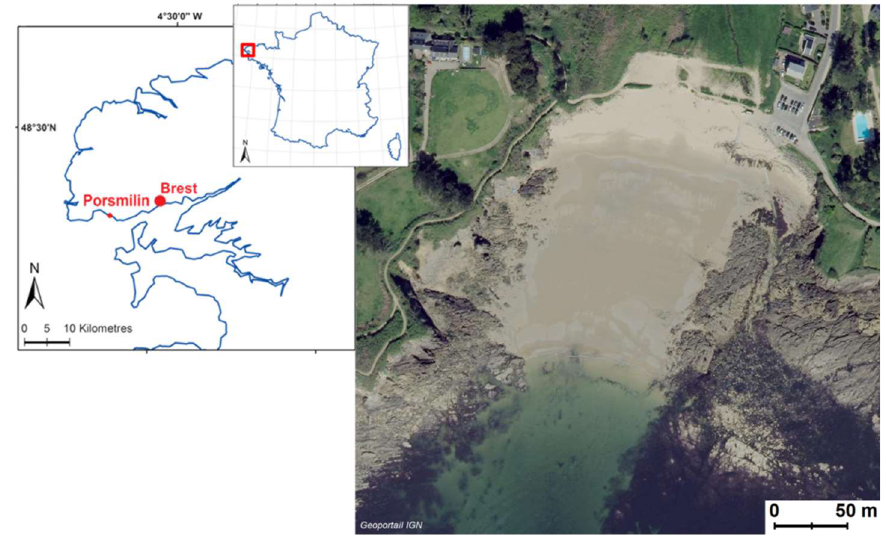
Figure 1. Location and orthophotograph of Porsmilin Beach (Geoportail IGN © —2015).